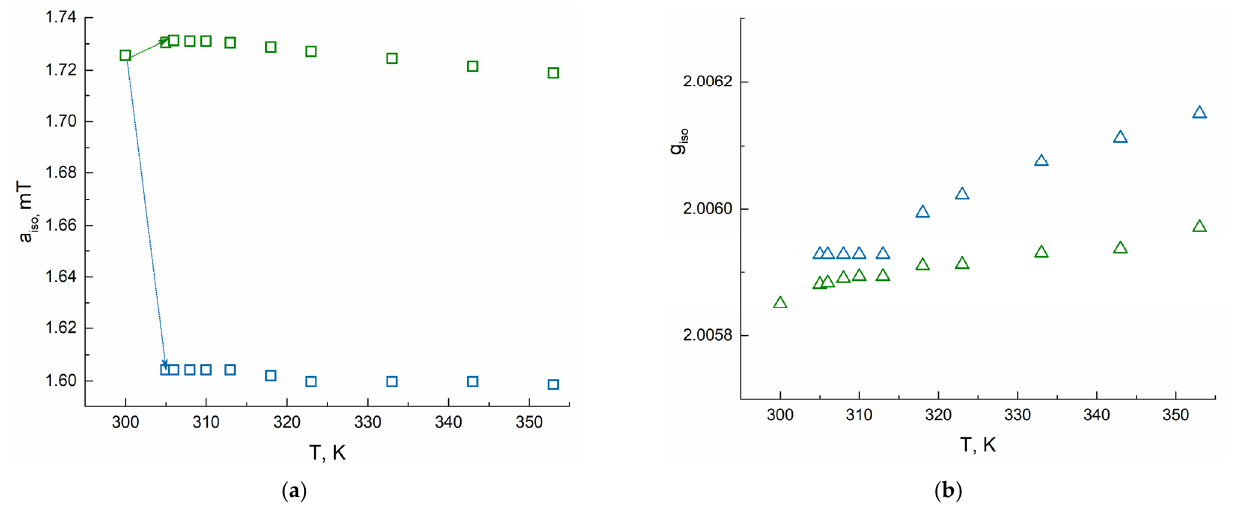
Figure 5. Change of a iso ( a ) and g iso ( b ) of TEMPO radical in PNIPAM solution with heating according to EPR spectra simulation. Green squares and triangles correspond to A particles, blue ones correspond to B particles.